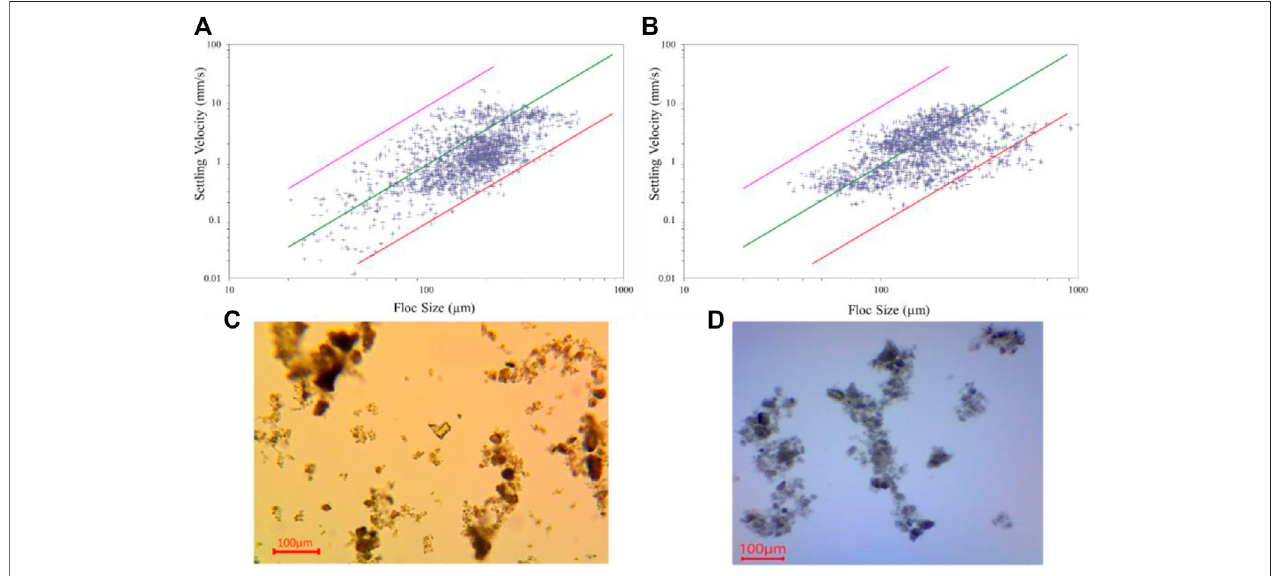
FIGURE 9 | Settling velocity as a function of fl oc size measured in the LabSFLOC-2 experimental setup. (A) pure bentonite and (B) bentonite with EPS. The solid linesprovide settling velocitiesfor different effective densities according to Eq. 7 (magenta ρ e (cid:1) 1600 kg/m 3 , green ρ e (cid:1) 160 kg/m 3 and red ρ e (cid:1) 16 kg/m 3 ).The bottom panelsshow examples of microscopy images of (C) bentonite and (D) bentonite with